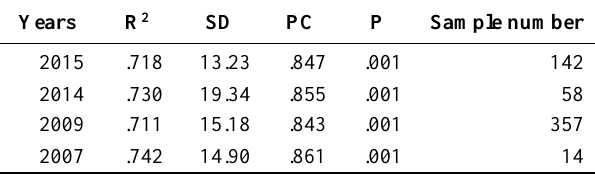
Table 2. Comparisons between the modeled and field observed net primary productivity